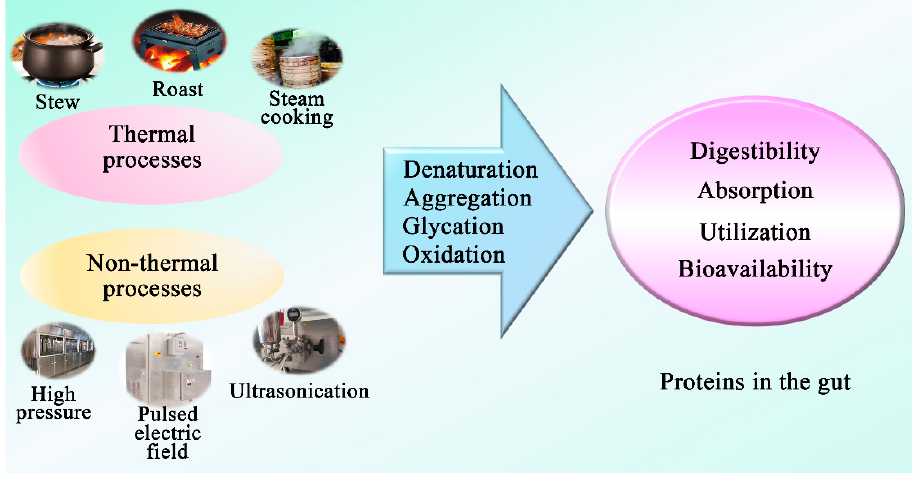
Figure 4. The effect of food processing on protein to influence gut microbiota.